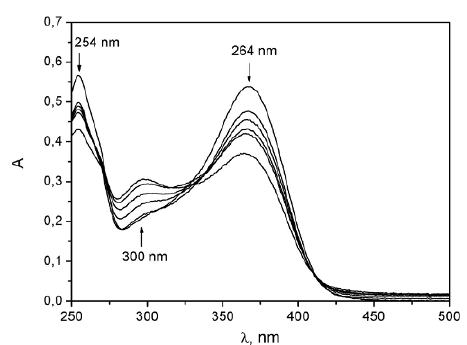
Figure 2. Absorption spectra of 20 µM quercetin taken after 0.5 min incubation with peroxynitrite at concentrations: 0, 50, 100, 150, 200 and 250 µM, at pH